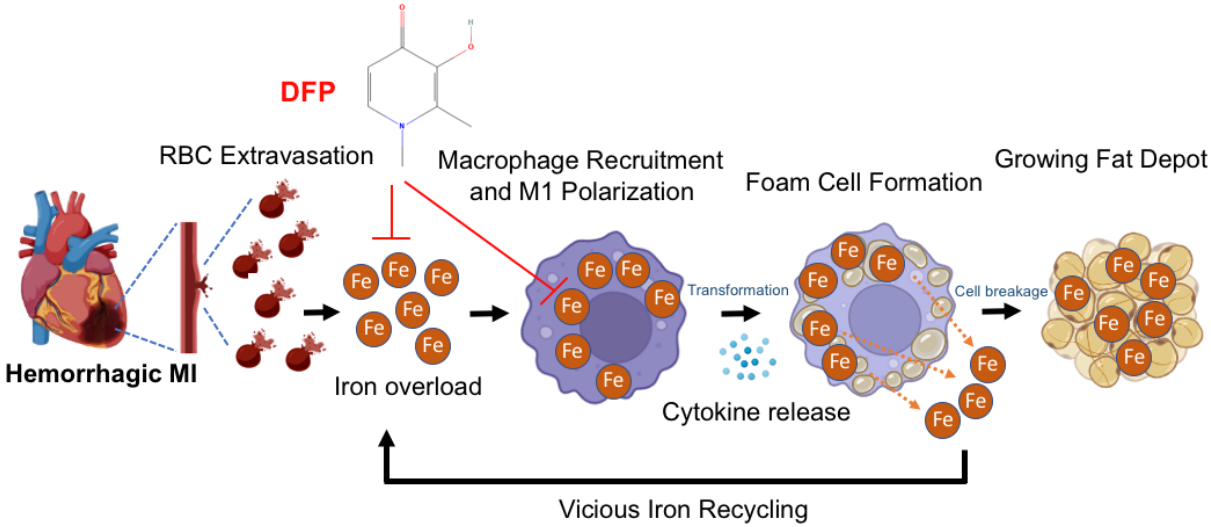
FIGURE 2: A proposed scheme of how hemorrhagic myocardial infarction (MI) induces iron accumulation, proinflammatory response and lipomatous metaplasia. In hemorrhagic myocardial infarction (MI), the extravasated red blood cells (RBCs) lead to iron overload and pro- mote the recruitment of unpolarized macrophages to the infarction zone. This iron when taken up by macrophages induce their polarization into pro-inflammatory state and subsequently transformation into foam cells through disproportionate lipid influx and cholesterol accumu- lation. As the disease progresses, iron is released through foam cell degradation (apoptosis), which enters a vicious cycle that perpetuates to continually support inflammation and leads to the growth of the fat depot in the infarction zone. These detrimental events contribute to functional and structural losses of the heart, which define chronic heart failure. Timely application of an intra- and extra-cellular ferric iron chelator deferiprone (DFP) can markedly reduce iron and fat with the MI zone. Figure was generated using